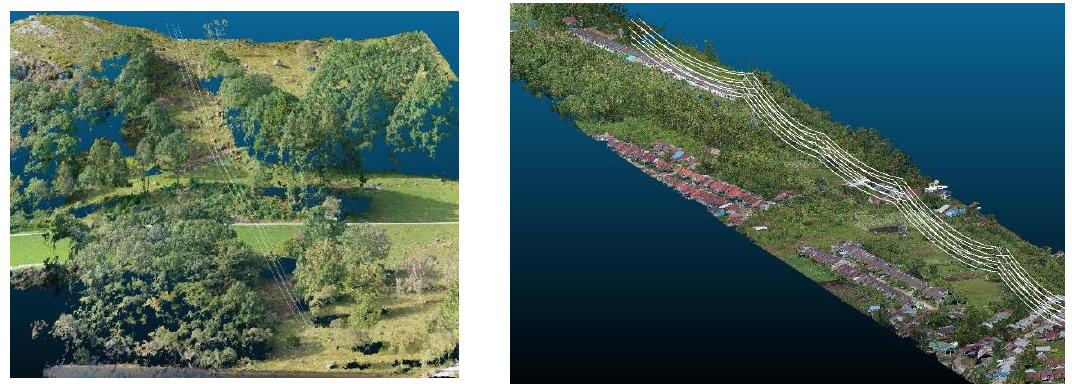
Figure 1. A visualization of the goal of the research, i.e., the results of the 3D reconstruction of power lines (source: FlyTech unmanned aerial vehicle (UAV) test flights)—power line over the UAV-derived point cloud representation of the digital surface model (DSM).